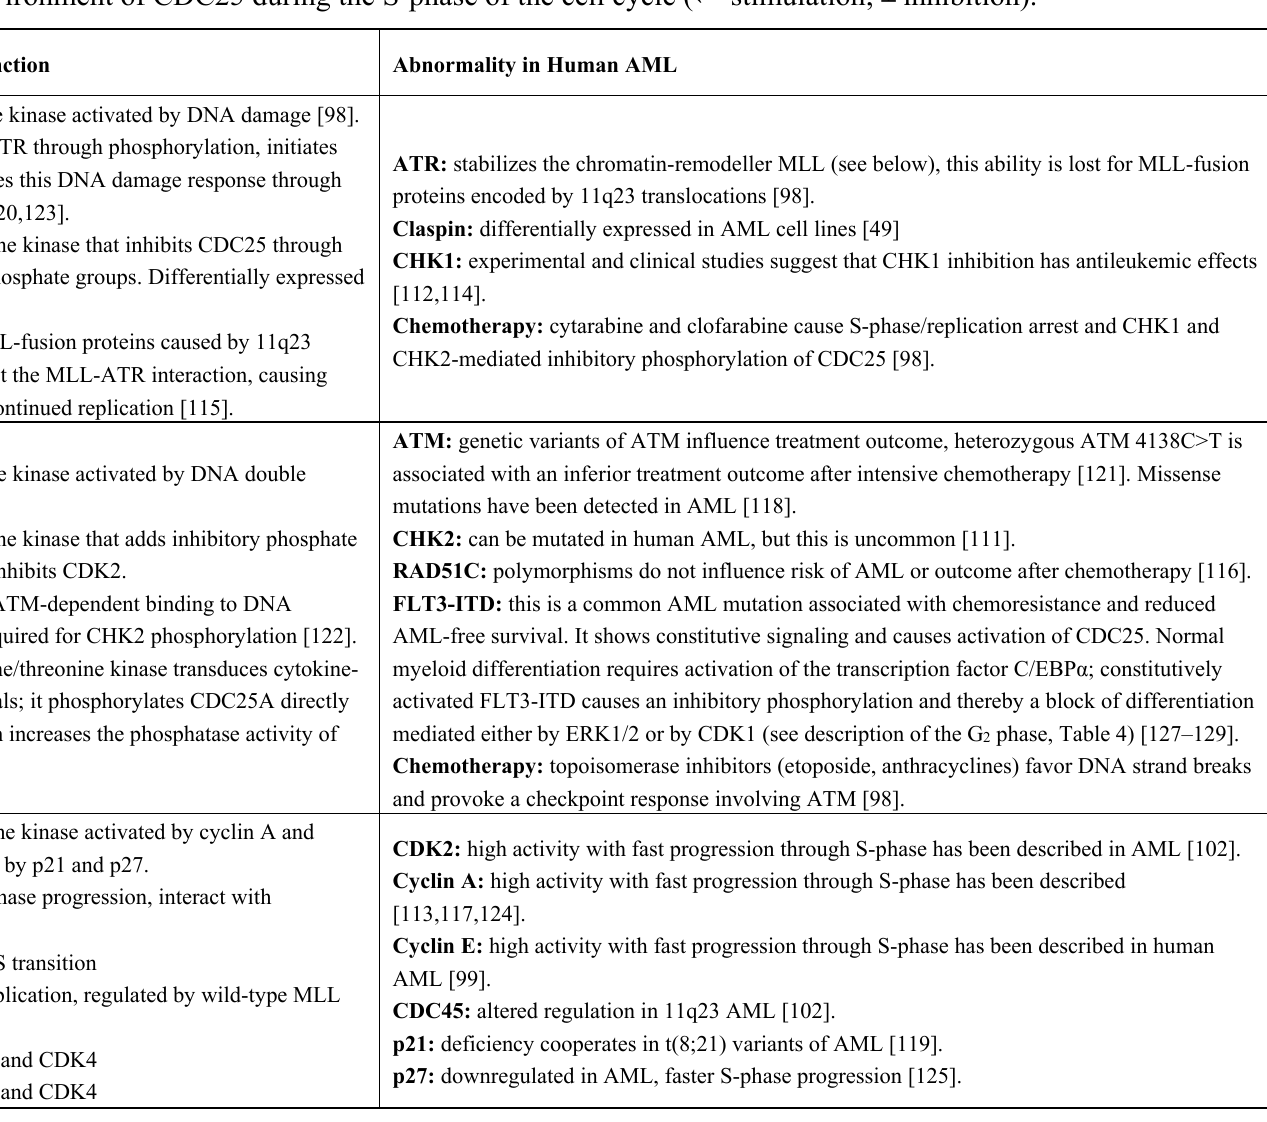
Table 3. The molecular environment of CDC25 during the S-phase of the cell cycle ( ← stimulation; ┴